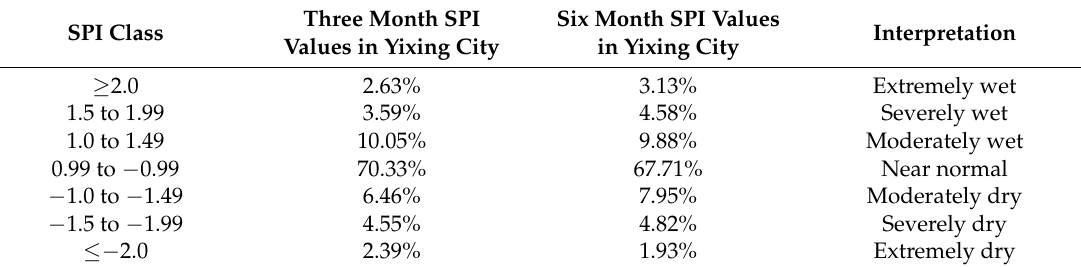
Figure 8. Lowest water levels in Hengshan Reservoir from 2004 to 2011. Table 3. Three- and six-month SPI values for Yixing City from 1980 to 2014.